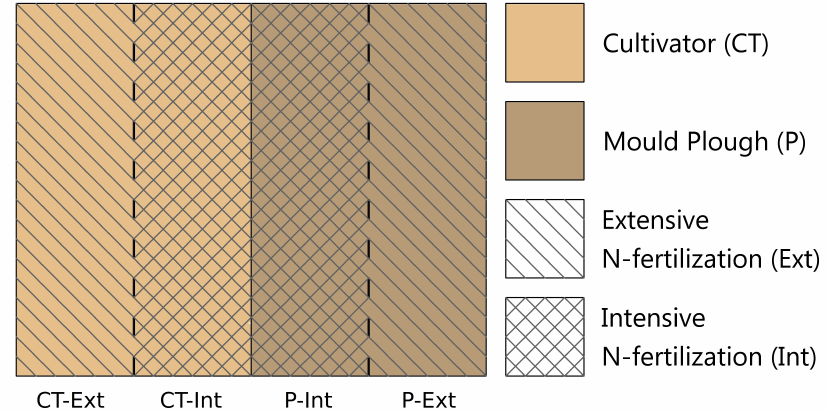
Figure 1. Schematic representation of the soil cultivation treatment regime of the studied parcel of the LTE-1 (long-term experimental) field site at BBG-Strenzfeld (Bernburg, Saxony-Anhalt). Field strips were treated as follows: (i) ploughed with standard (intensive) N-fertilization and application of fungicides and growth regulators (P-Int), (ii) ploughed with reduced N-fertilization (50% of intensive, P-Ext), (iii) cultivator treatment with standard N-fertilization and application of fungicides and growth regulators (CT-Int) and (iv) cultivator treatment with reduced fertilization (CT-Ext). Subsequently to a greenhouse experiment involving lettuce as as model plant, total community (TC)-DNA was extracted considering the additional factors bulk soil (BS) and root-affected soil